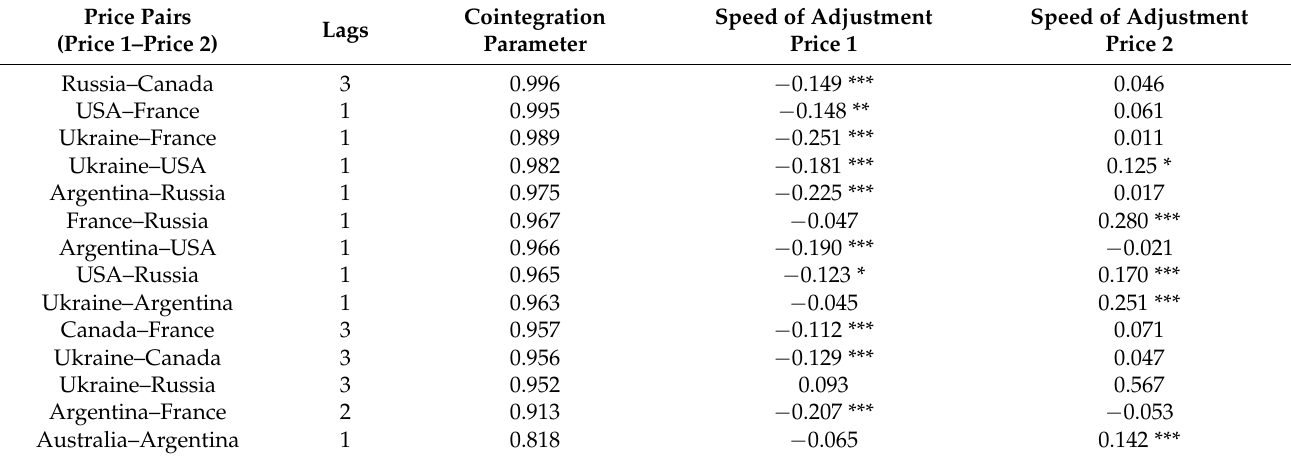
Table 4. Estimated parameters of